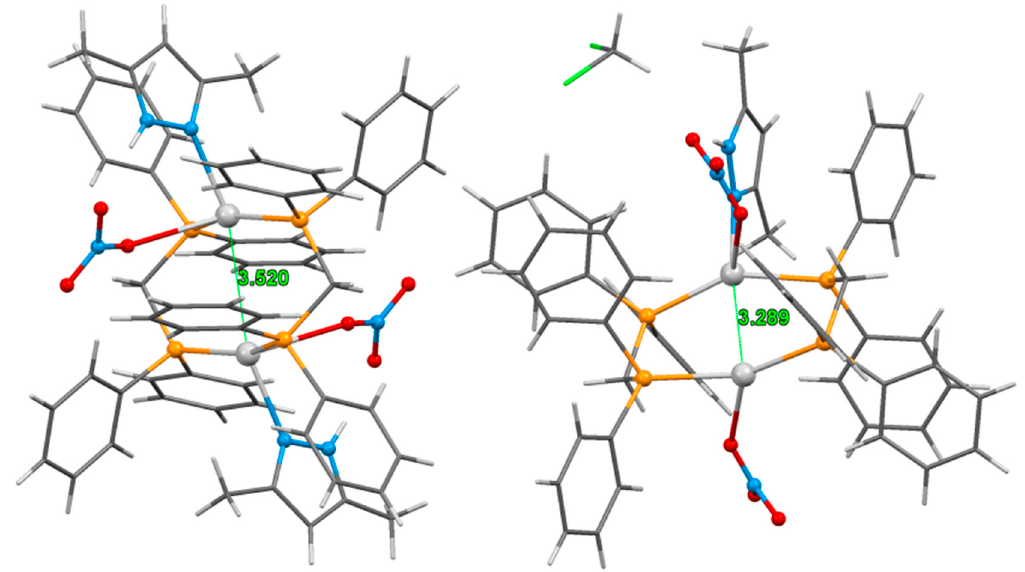
Figure 4. XRD structure of the co-crystal 2a/2b and dichloromethane (DCM) molecule (carbon, hydrogen, and chlorine atoms are shown as sticks).